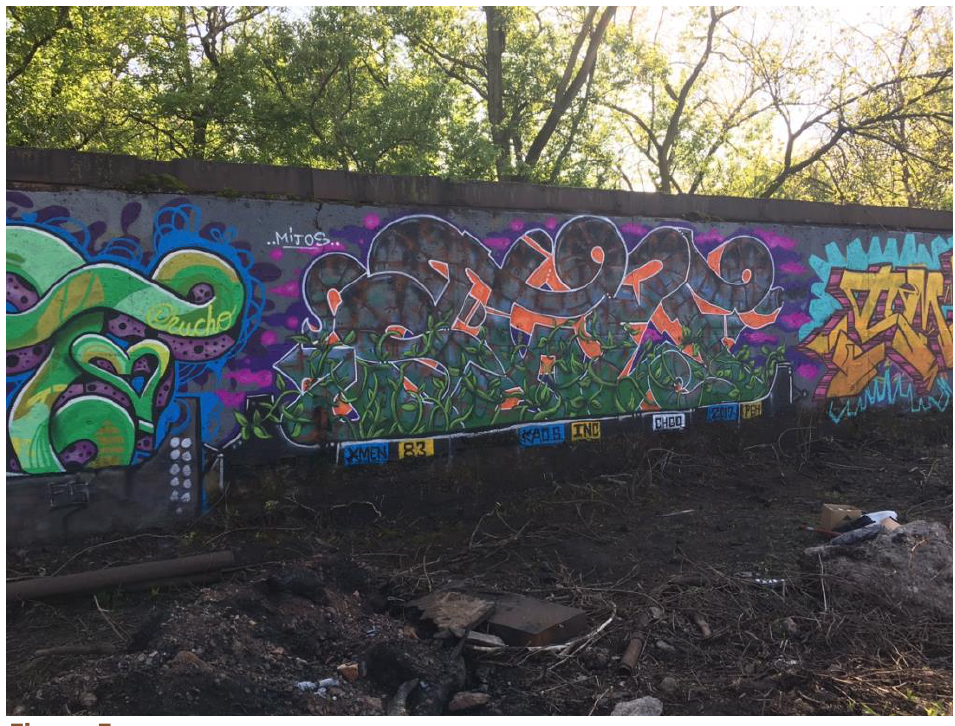
Caitlin Frances Bruce, Stef piece, Aerosol paint on wall, 2017, Rankin, Pennsylvania. Copyright: